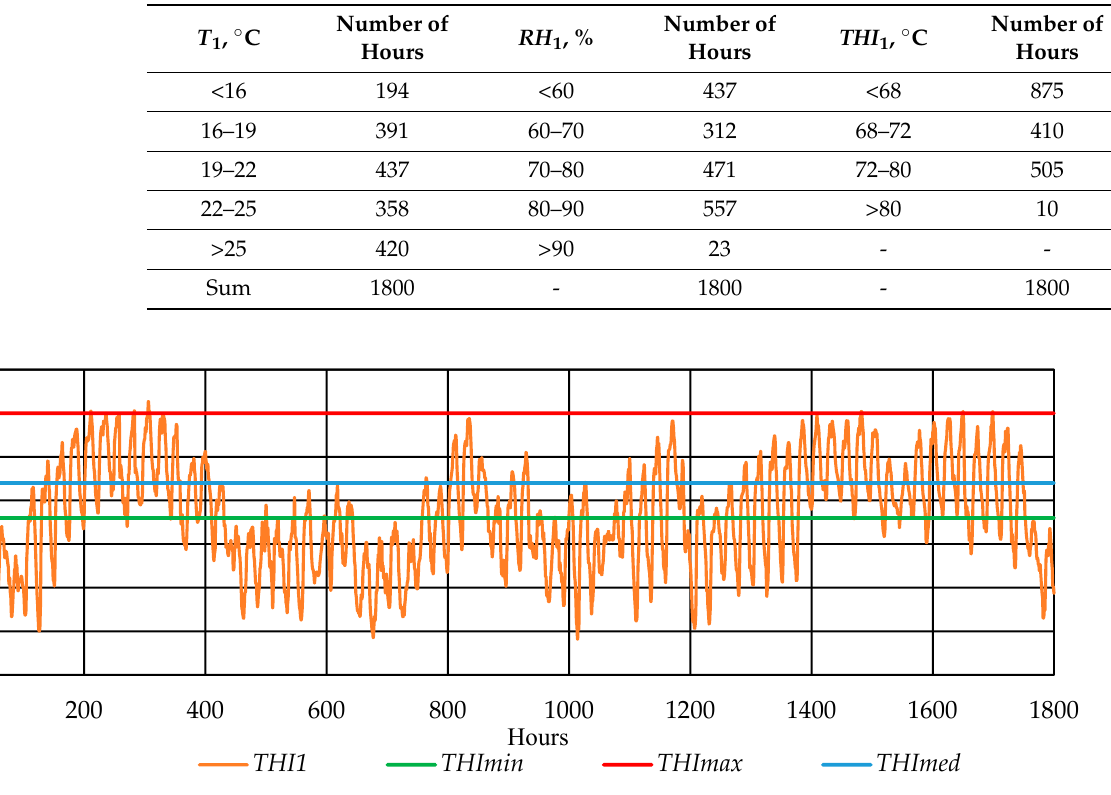
Figure 4. Dynamics of changes in temperature humidity index ( THI 1 ) in the period from 18.06.2022 to 31.08.2022 (1800 h) calculated on the basis of temperature and relative humidity of the air entering the cowshed from outside.